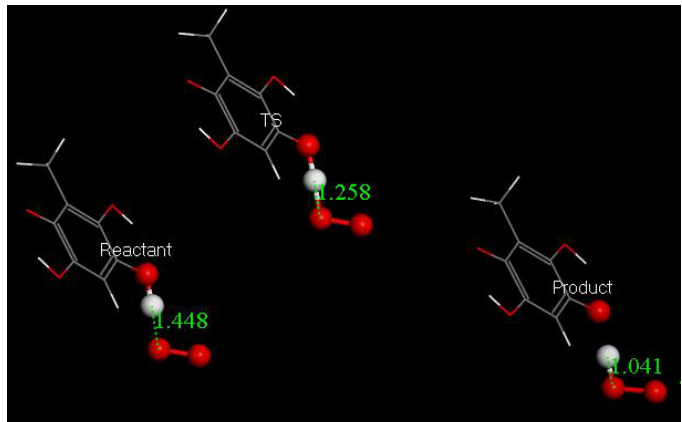
Figure 12. Reagent, Transition State and Product for semiquinone [embelin] •− capturing H + from vitamin C to form embelin-H. ΔG = −0.8kcal/mol, E Barrier = 0.2 kcal/mol.